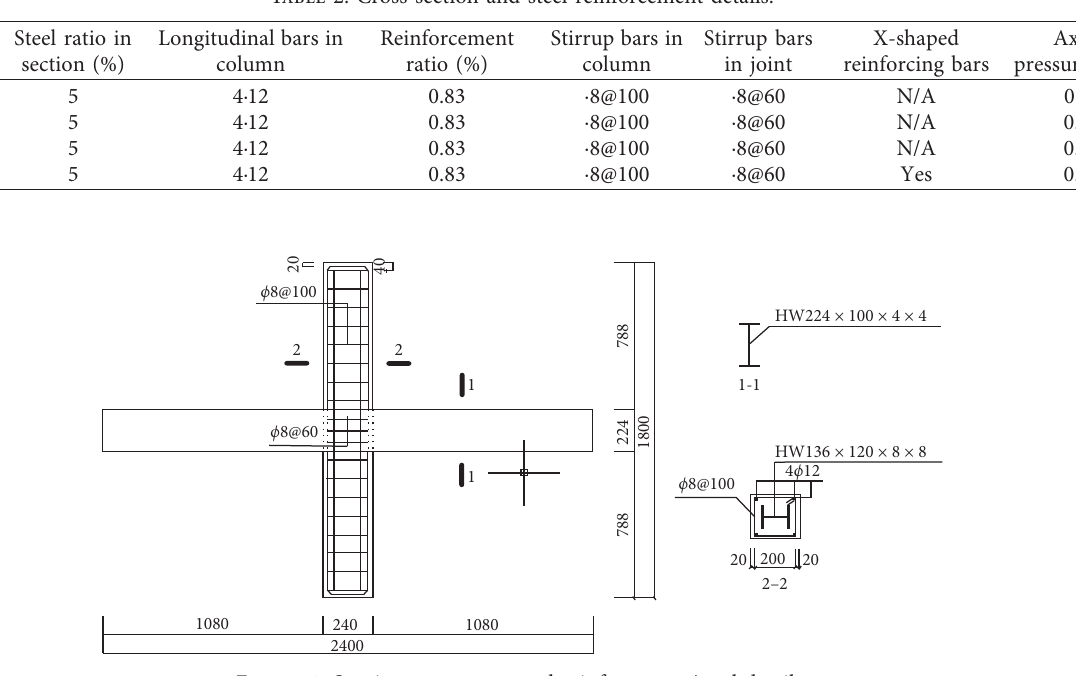
Figure 1: Specimen geometry and reinforcement/steel details.